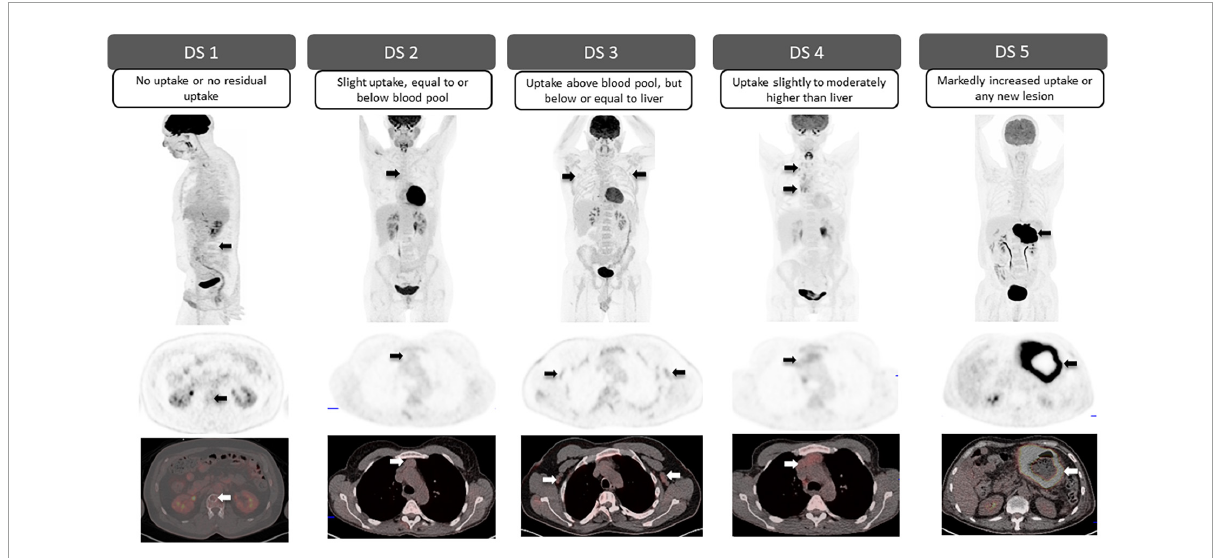
FIGURE1 Deauville 5-point scale. Visual grading for each Deauville score (DS) according to the degree of FDG uptake in the mediastinal blood pool (MBP) and liver. Arrows point to residual lesions for each DS ( top row : sagittal or coronal PET; middle row : axial PET; bottom row : fused axial PET/CT).